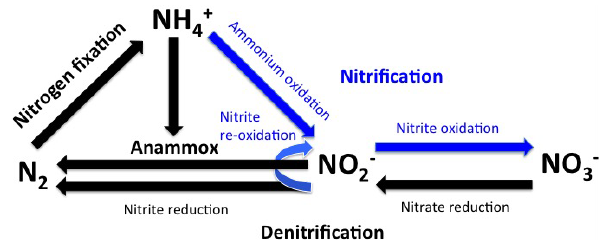
Figure 1. Simplified schematic view of the nitrogen